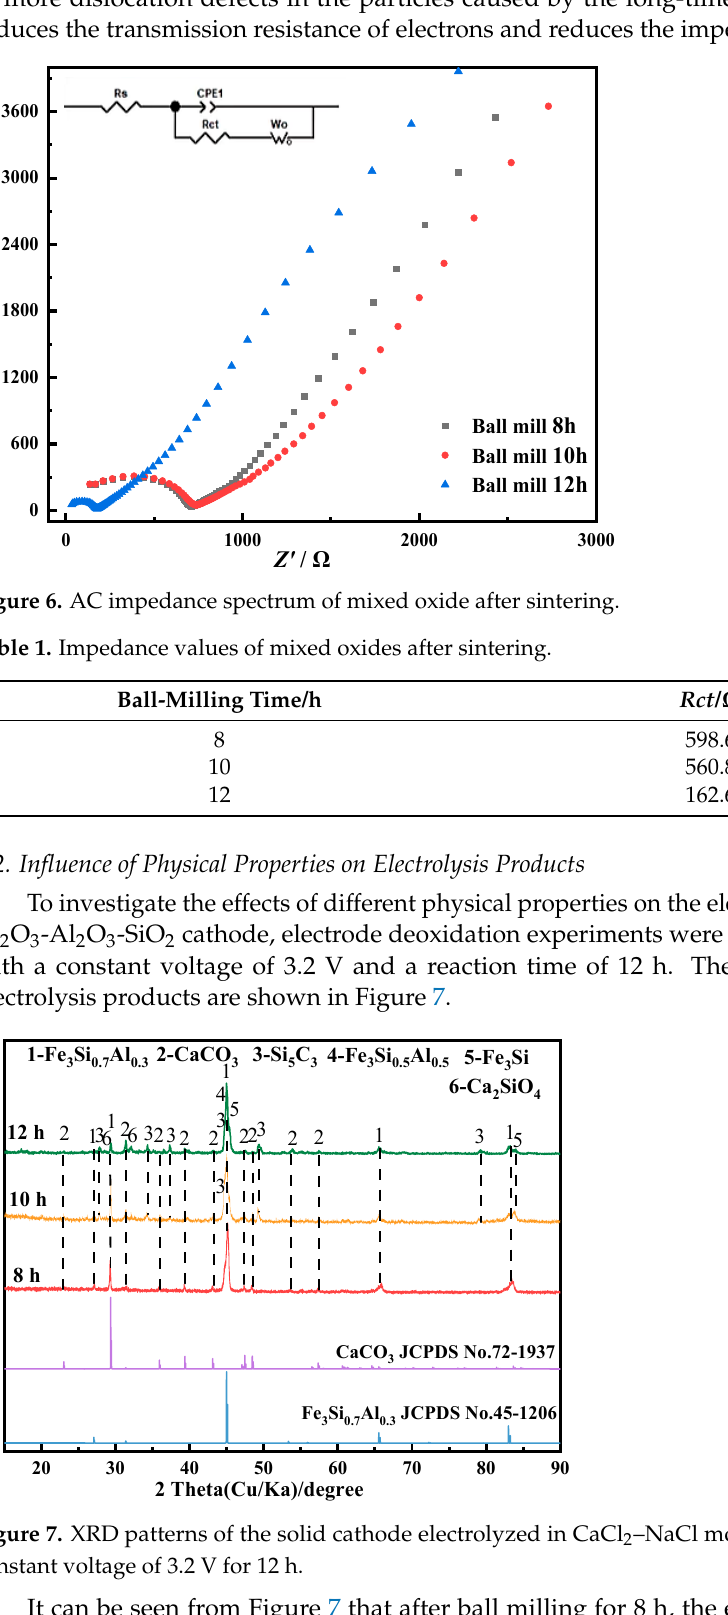
Table 1. Impedance values of mixed oxides after sintering.